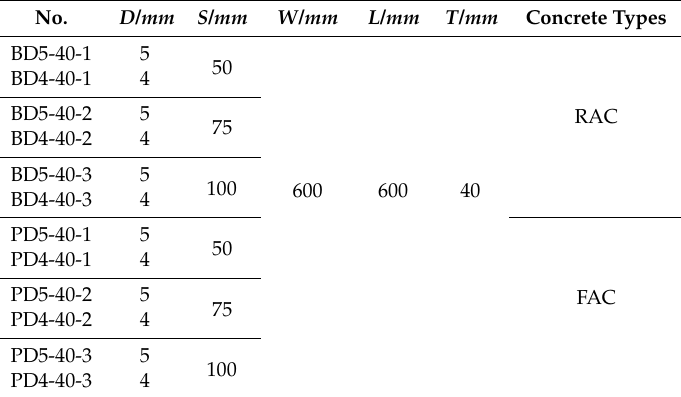
Table 2. Parameters of specimens.